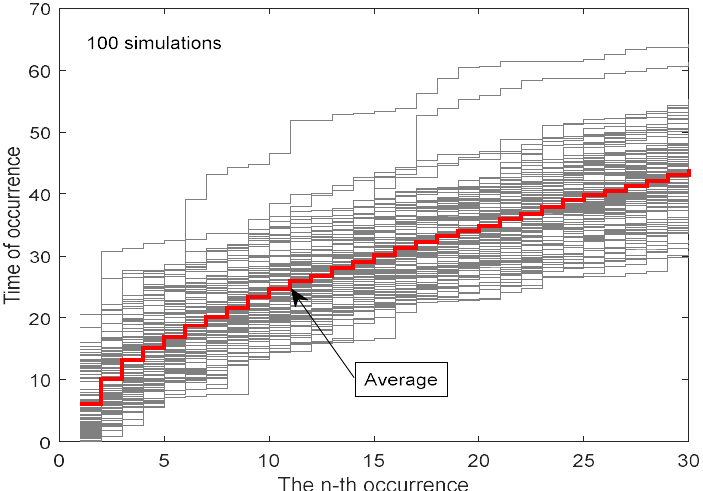
Figure 3. Simulated water main breaking events using the TTS point process model assuming α = 0.1, β = 0.6, and γ = −